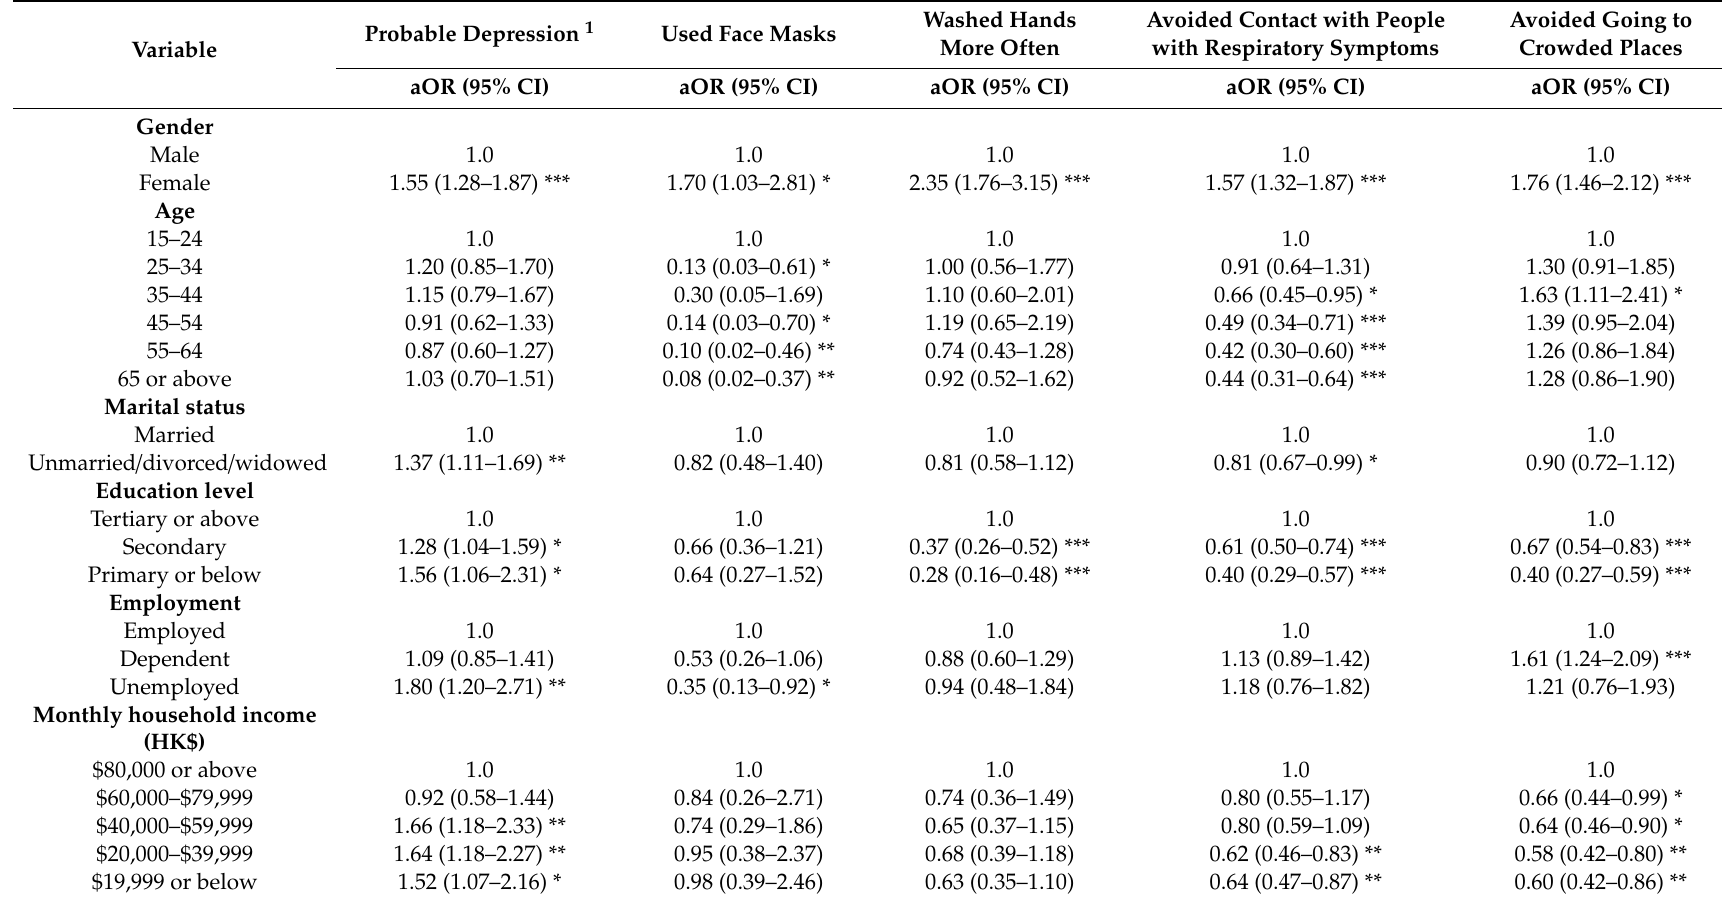
Table 3. Multivariable logistic regression examining the associations of social capital with probable depression and adoption of preventive